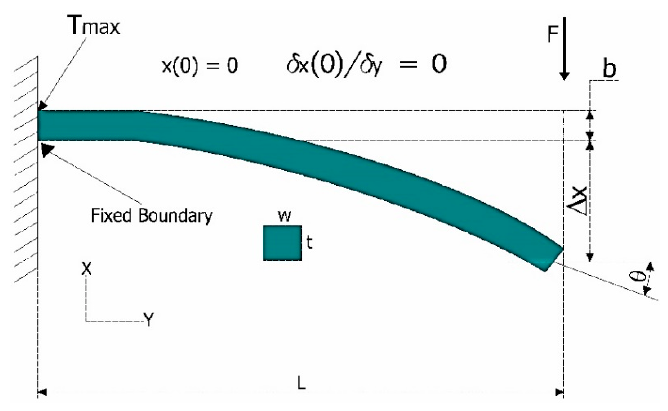
Figure 2. Cantilever